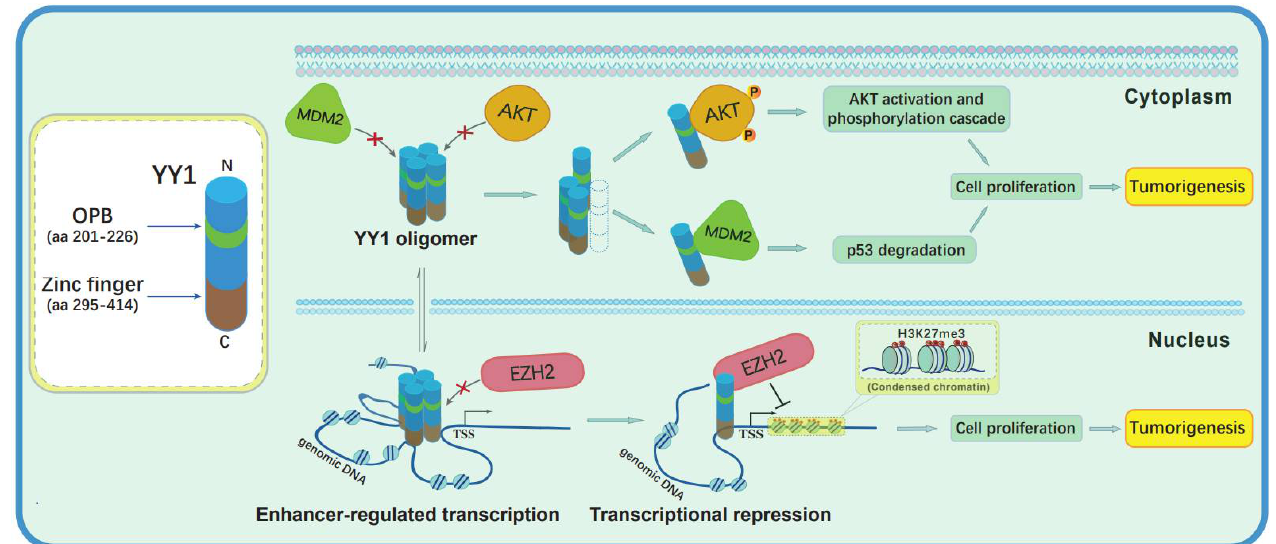
Figure 6. A schematic model of competitive processes between YY1 oligomerization and its interac- tions with different oncoproteins. In the nucleus, YY1 oligomers may activate target gene expression through facilitating enhancer formation, but may not be able to bind the oncoproteins. As monomers, YY1 interacts with EZH2, AKT and MDM2 in either the nucleus or cytoplasm to promote their oncogenic activities, including suppressing tumor suppressive genes, stimulating proliferative signaling pathways, and enhancing p53 ubiquitination and degradation, respectively.